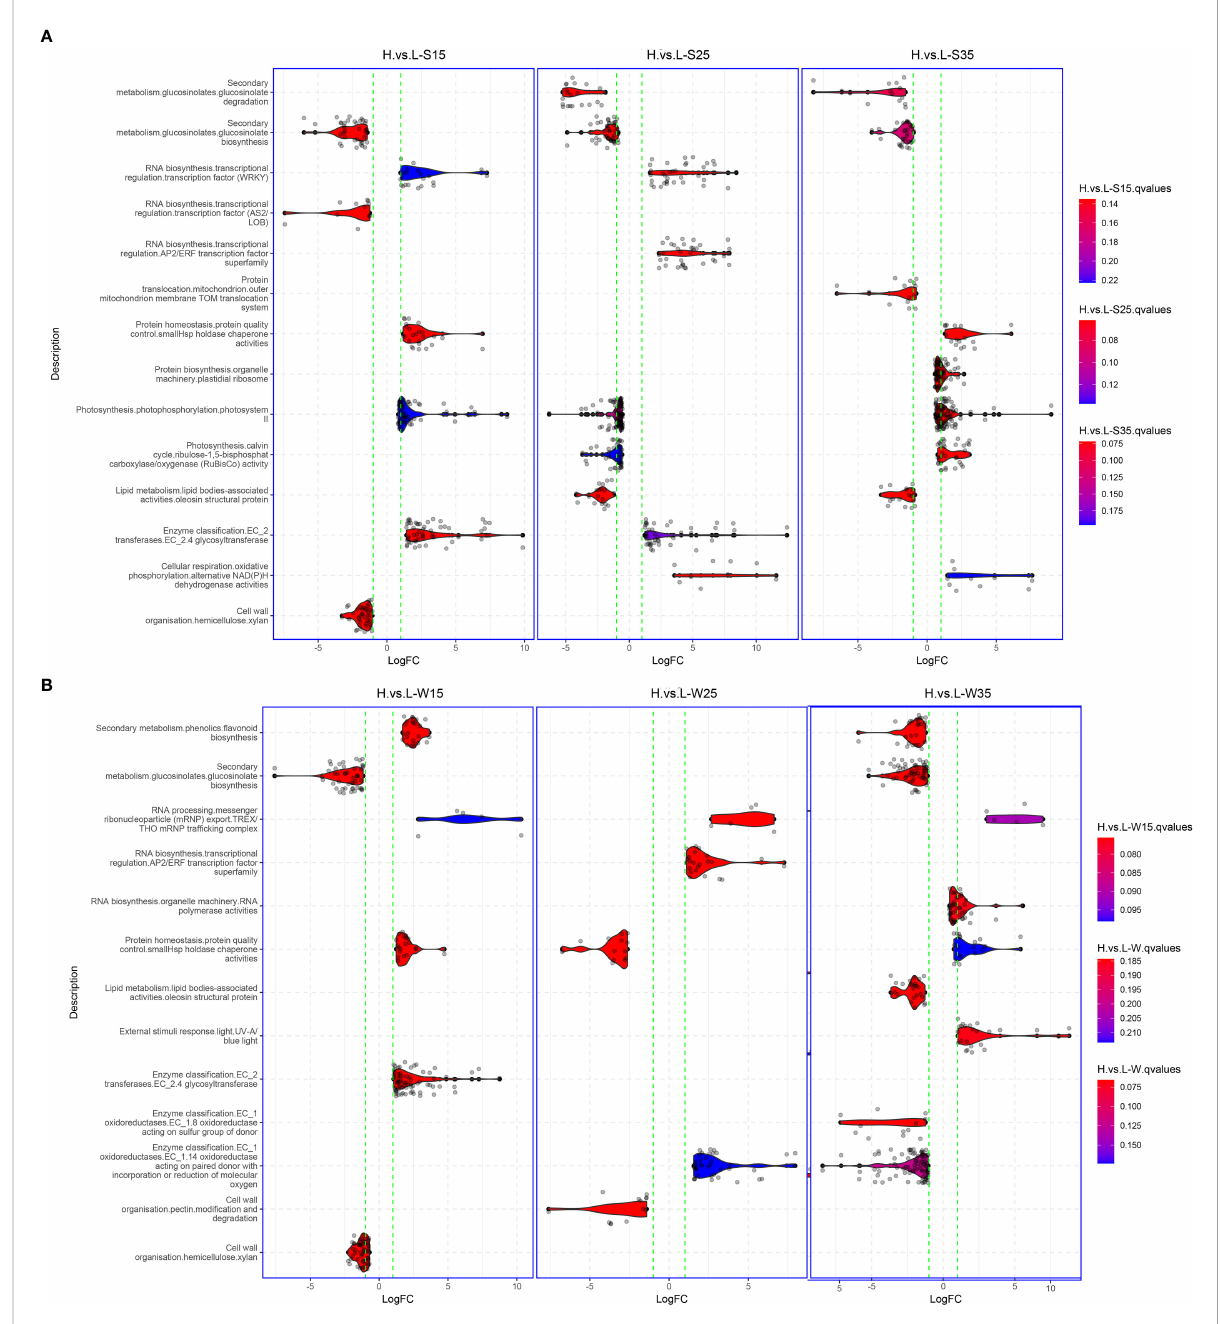
FIGURE 6 Gene set enrichment analysis between L192 and A260. (A) Different pathways at 15, 25 and 35 DAF in the developing seed. (B) Different pathways at 15, 25 and 35 DAF in the developing silique walls. Gene sets were obtained using Mercator4 (Schwacke et al.,